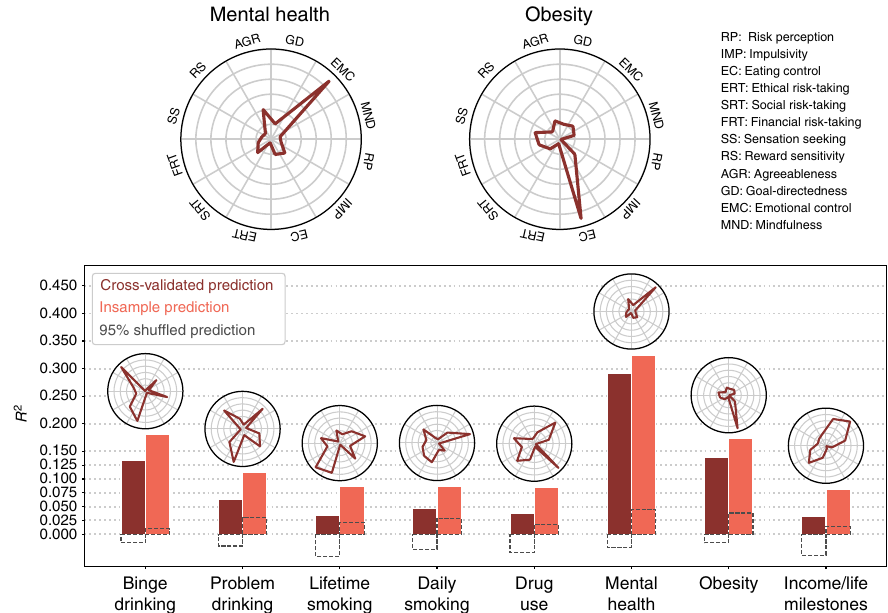
Fig. 6 Prediction of target outcomes using survey factor scores. Cross-validated (dark bars) and insample (light bars) R 2 are shown. Dashed gray boxes indicate 95% of null distribution, estimated from 2500 shuf fl es of the target outcome. Ontological fi ngerprints displayed as polar plots indicate the standardized β for each survey factor predicted above chance (randomization test: p < 0.05). The ontological fi ngerprint for the two best-predicted outcomes are reproduced at the top. The y -axes are scaled for each fi ngerprint to highlight the distribution of associations — no inference can be drawn comparing individual factor magnitudes across outcomes (see Fig. 8 to do this)